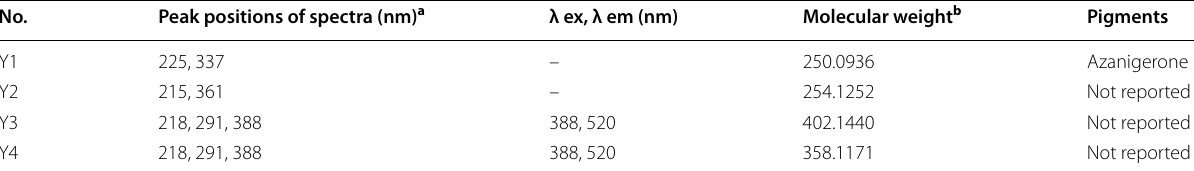
a Detected by HPLC-PDAD b Detected by LC–MS